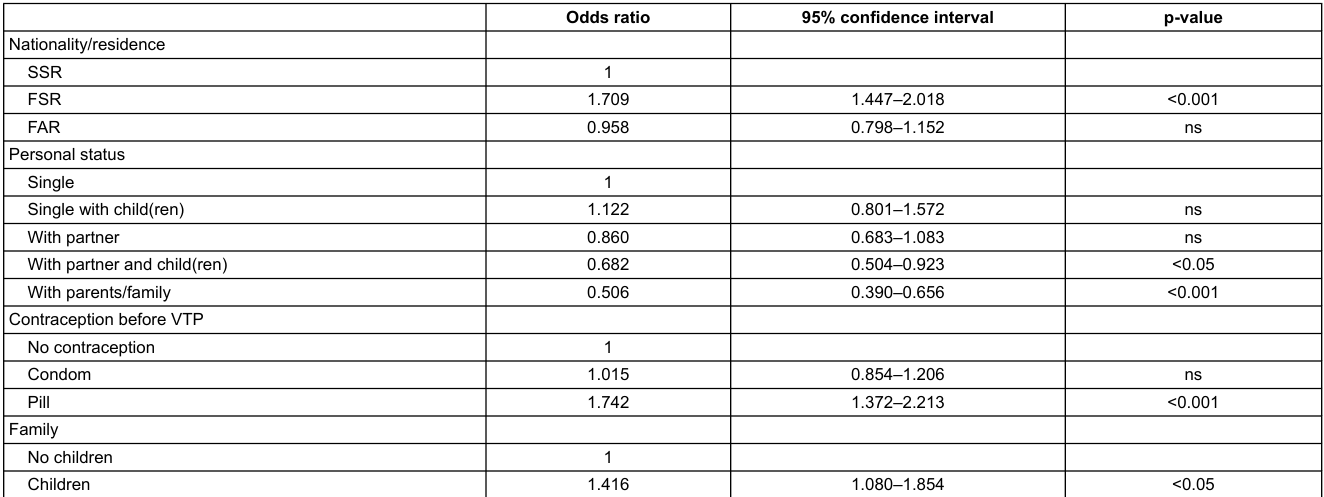
Table 5: Multiple VTP (regression